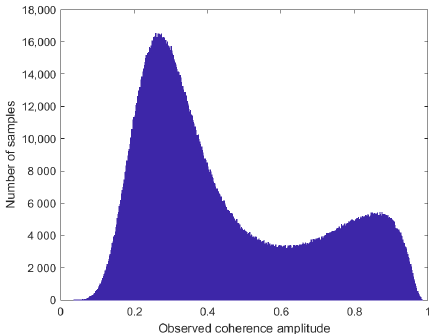
Figure 10. The distribution of observed coherence amplitude.